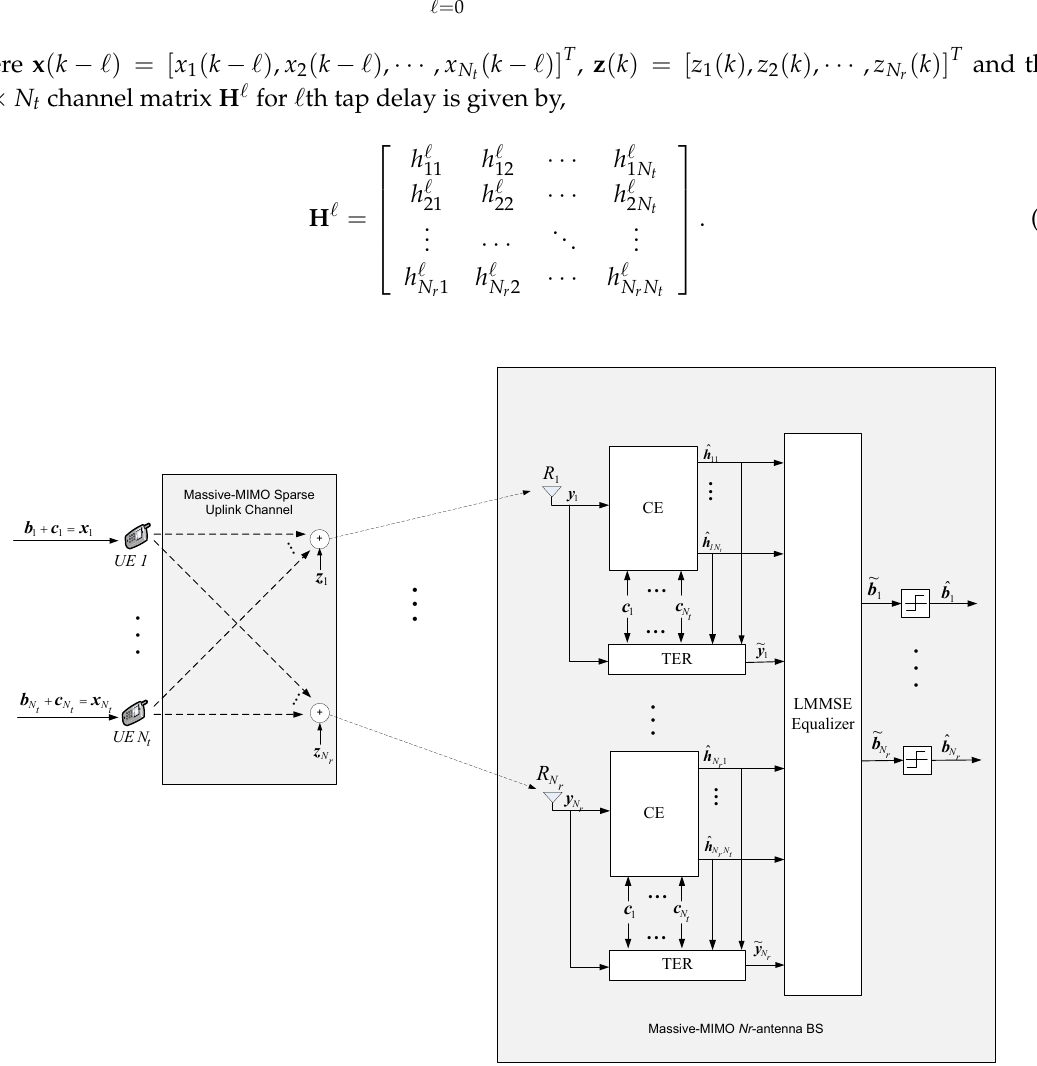
Figure 1. Proposed system model for massive multiple-input multiple-output (massive-MIMO) uplink